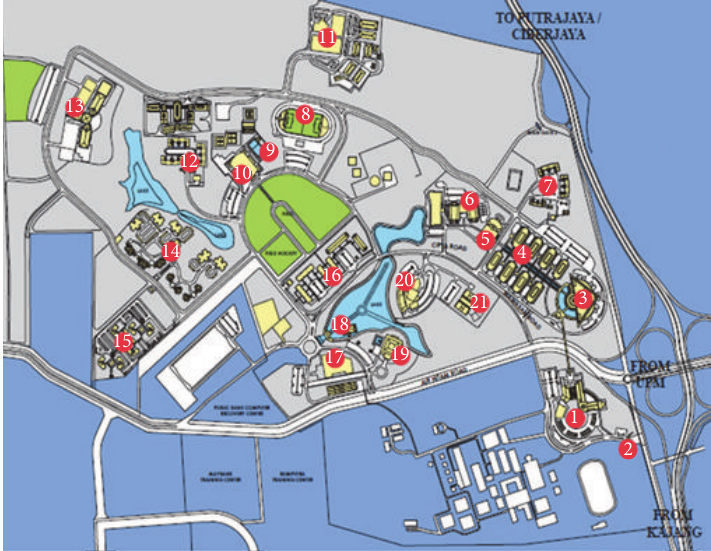
Figure 2: Map of Universiti Tenaga Nasional. (1) Library, (2) Main Gate, (3) Administration Building, (4) Laboratory and Training Block, (5) COE Food court, (6) College of Engineering, (7) Murni Apartment, (8) Mini Stadium, (9) Multipurpose Hall, (10) TNB Equestrian Centre, (11) Cendekiawan Apartment, (12) College of Information Technology, (13) Staff Quarters, (14) Amanah Apartment, (15) Ilmu Apartment, (16) Food court 1, (17) Lake Caf´e, (18) Mosque, (19) Residence Hotel, and (20) Twin Tutorial Hall.